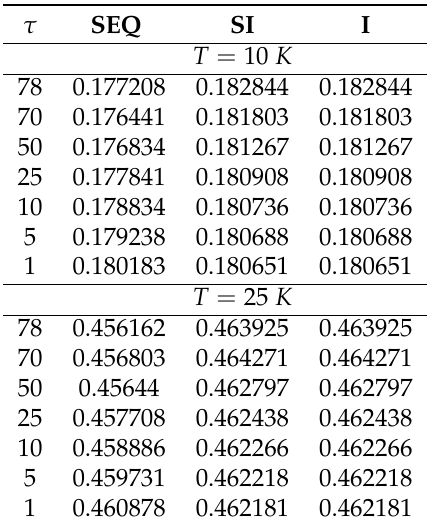
Figure 3. Plots of S h for different time steps τ (denoted on figure by dt ), and different time-stepping variants fully implicit (I), semi-implicit (SI), and sequential (SEQ). ( left ) Plots over the full range of depth and S h are essentially indistinguishable. ( right ) The zoom of the left plot shows a small sensitivity to the choice of time step and of the model variant. Table 2. Maximum hydrate saturation S h obtained with different model variants and time steps at T = 10 K and T = 25 K , all parameters as in base